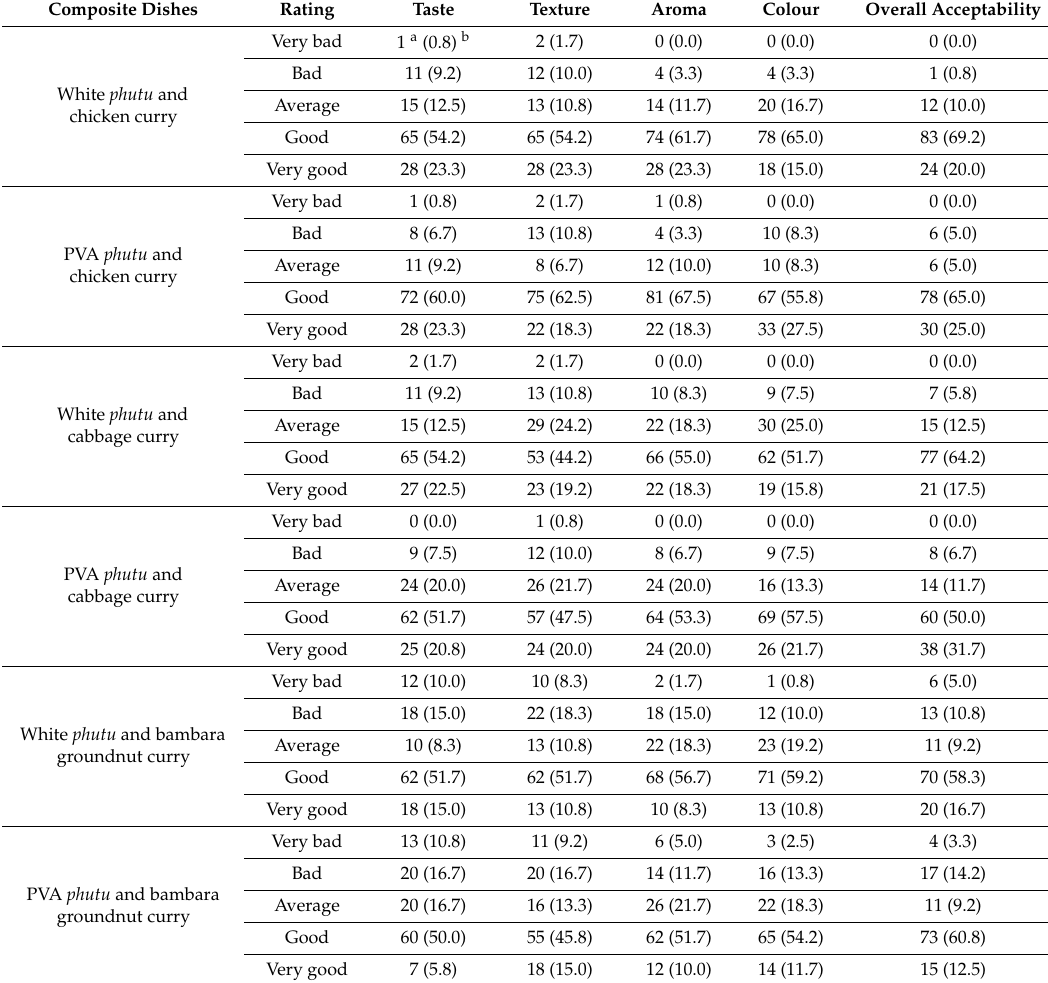
Table 4. Number and percentages of panellists who gave the di ff erent ratings for the sensory attributes evaluated ( n = 120).